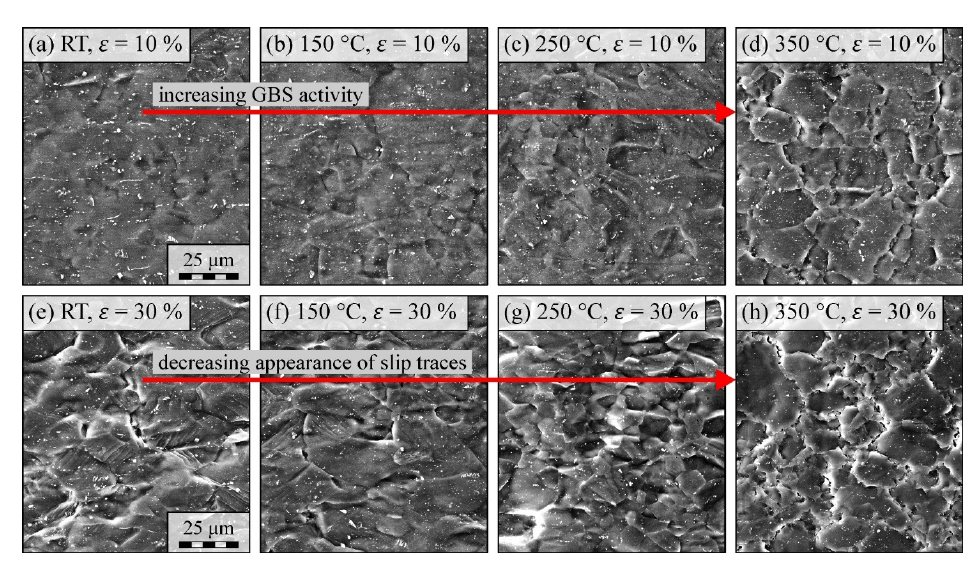
Figure 5. Example of a 150 °C simple shear specimen (loading direction indicated by blue arrows) with a tracked particle indicated by red circles and the orientation of slip traces indicated by red arrows; elongation 𝜀 indicated with reference to the initial gauge length of 1 mm being ( a ) 50%, ( b ) 80% and ( c ) 110%.